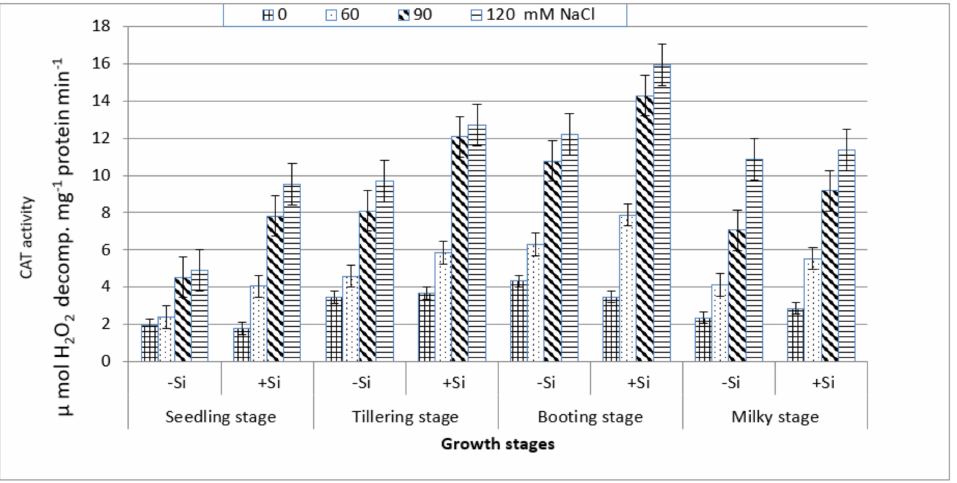
Figure 6. Effect of NaCl on catalase (CAT) activity in wheat leaves at different growth stages in the presence and absence of